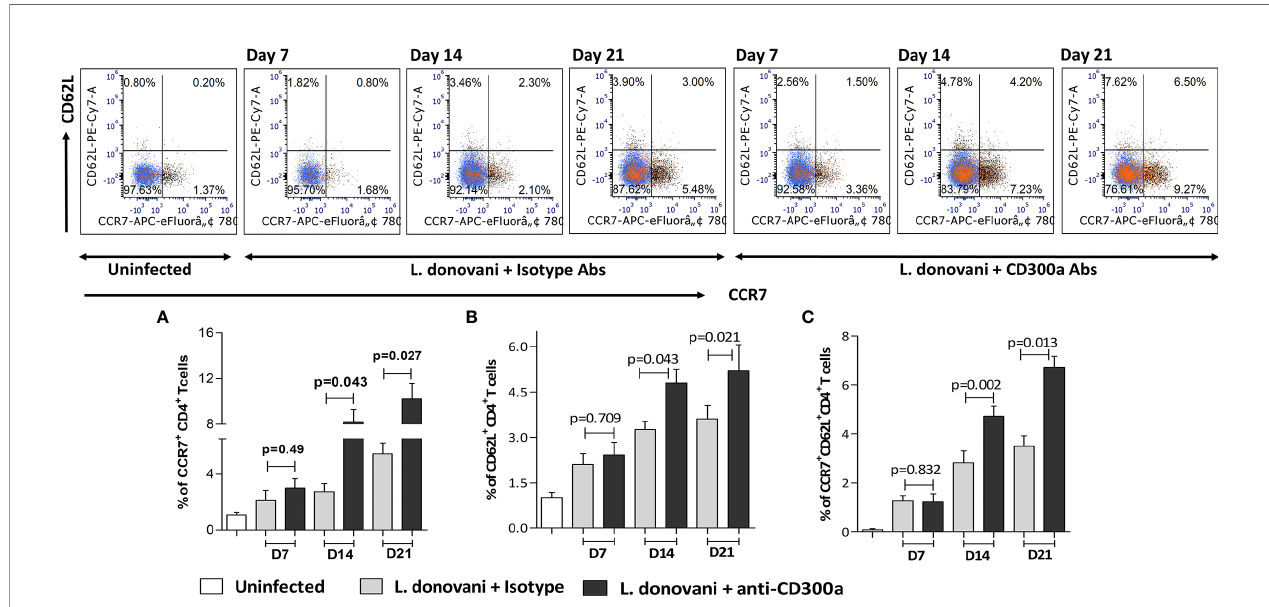
FIGURE 6 | The memory phenotypes, i.e., CCR7 + CD62L + CD4 + T cells in lymph nodes after CD300a blocking in infected animals. The number of CD4 + T cells expressing effector and central memory surface markers i.e., CCR7 + (A) , CD62L + (B) along with double positives CCR7 + CD62L + central memory CD4 + T cells (C) were signi fi cantly higher at D14 and D21 in antibodies treated animals as compared to those who received isotypic